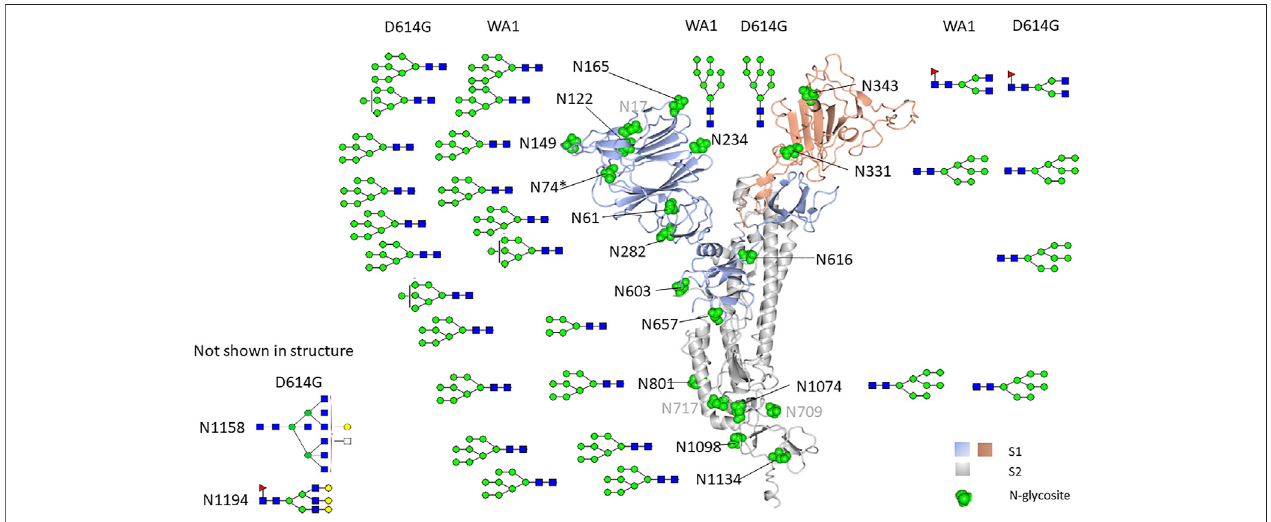
FIGURE 7 | N-glycosylation map of Vero E6-derived viruses. The most abundant glycoform detected in Vero E6 cell-derived WA1 and the D614G strain spike N-glycosite was comparable but different from that detected in recombinant S1 produced in HEK293.